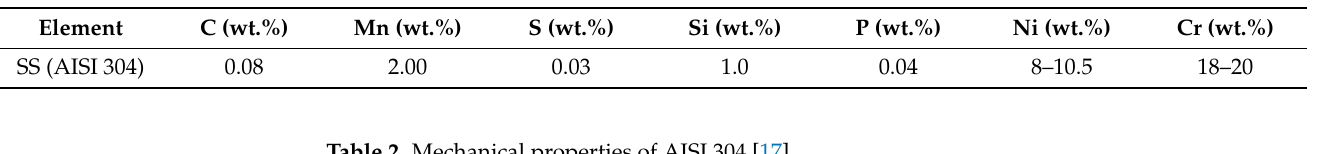
Table 1. Composition of AISI 304 [17].